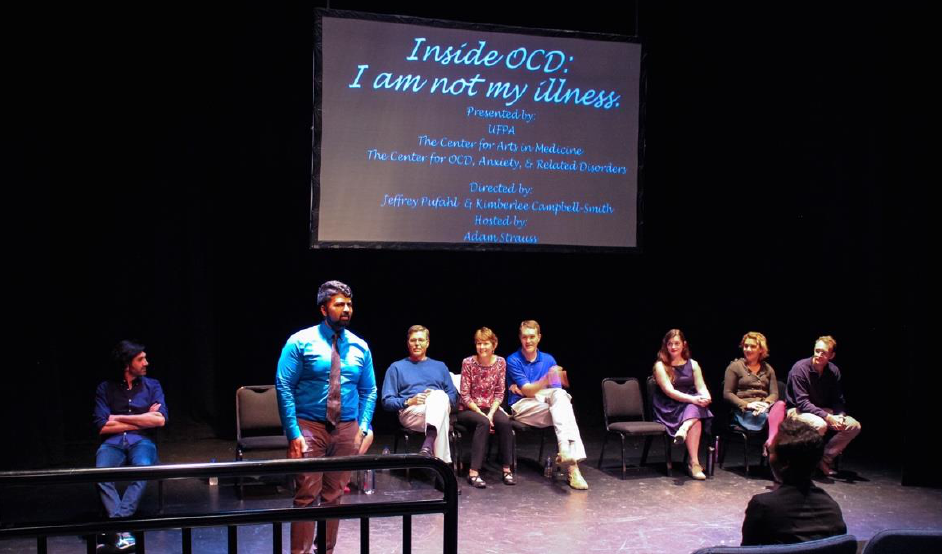
Figure 2. Participants perform “Inside OCD” at the University of Florida .